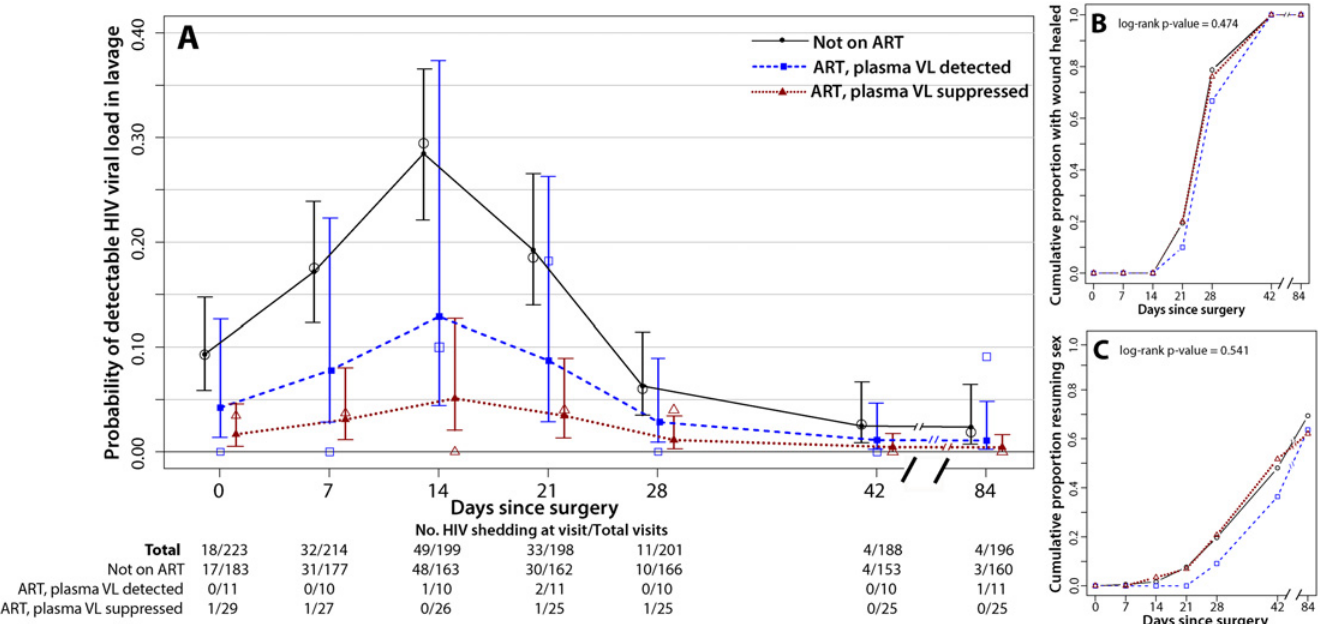
Fig 2. Penile HIV shedding, wound healing, and resumption of sex stratified by plasma viral load and ART status. The day 0 visit is prior to surgery. (A) HIV shedding from MC wounds increased at 7, 14, and 21 d after MC. The open symbols are the empirical data, and the filled symbols and line are the fit estimates. The error bars represent the 95% CIs of the fitted values. (B) There was no difference in certified wound healing between the three ART/VL groups. (C) There was no difference in the proportion of men resuming sex between the three ART/VL groups.